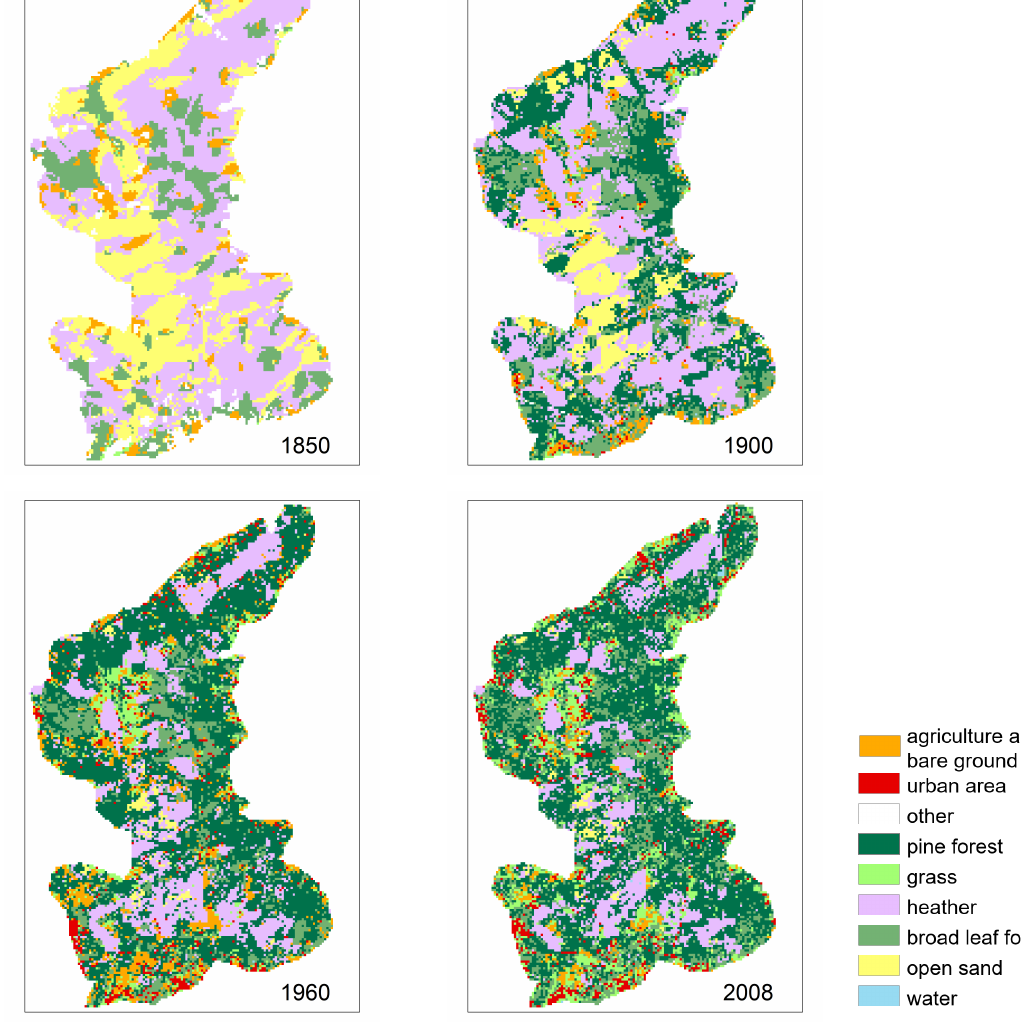
Figure 4. Historical land use across the